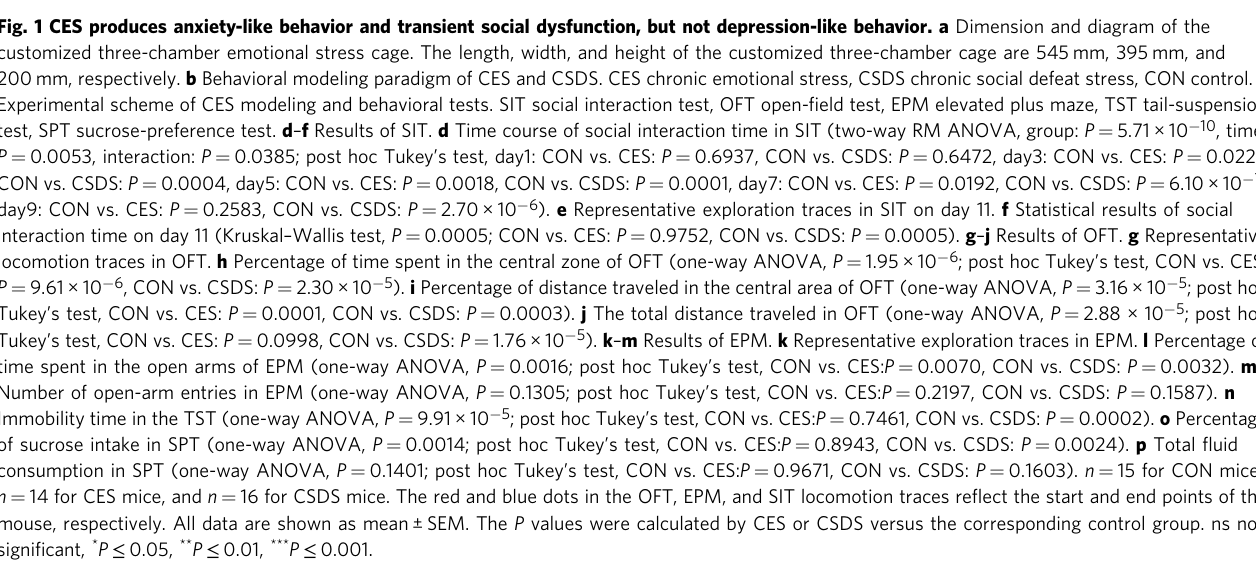
Fig. 1 CES produces anxiety-like behavior and transient social dysfunction, but not depression-like behavior. a Dimension and diagram of the customized three-chamber emotional stress cage. The length, width, and height of the customized three-chamber cage are 545 mm, 395 mm, and 200 mm, respectively. b Behavioral modeling paradigm of CES and CSDS. CES chronic emotional stress, CSDS chronic social defeat stress, CON control. c Experimental scheme of CES modeling and behavioral tests. SIT social interaction test, OFT open- fi eld test, EPM elevated plus maze, TST tail-suspension test, SPT sucrose-preference test. d – f Results of SIT. d Time course of social interaction time in SIT (two-way RM ANOVA, group: P = 5.71 × 10 − 10 , time: P = 0.0053, interaction: P = 0.0385; post hoc Tukey ’ s test, day1: CON vs. CES: P = 0.6937, CON vs. CSDS: P = 0.6472, day3: CON vs. CES: P =